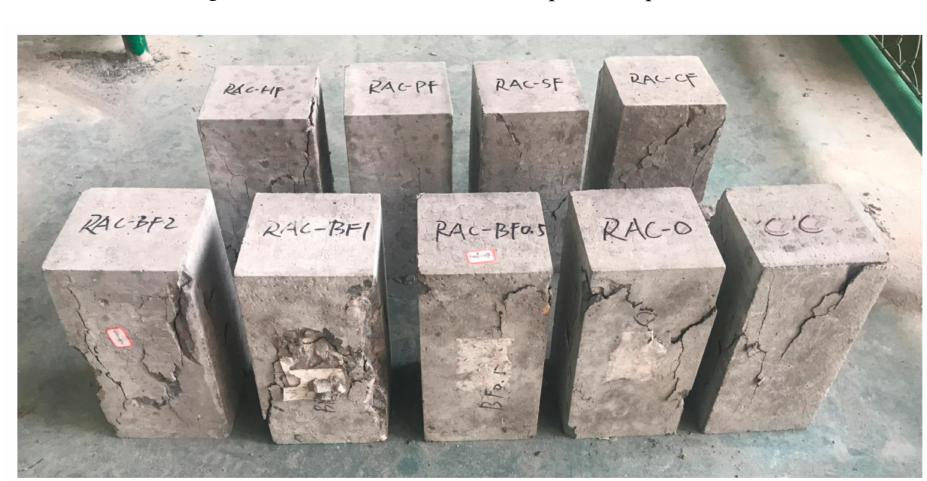
Figure 6. Failure modes of axial compressive